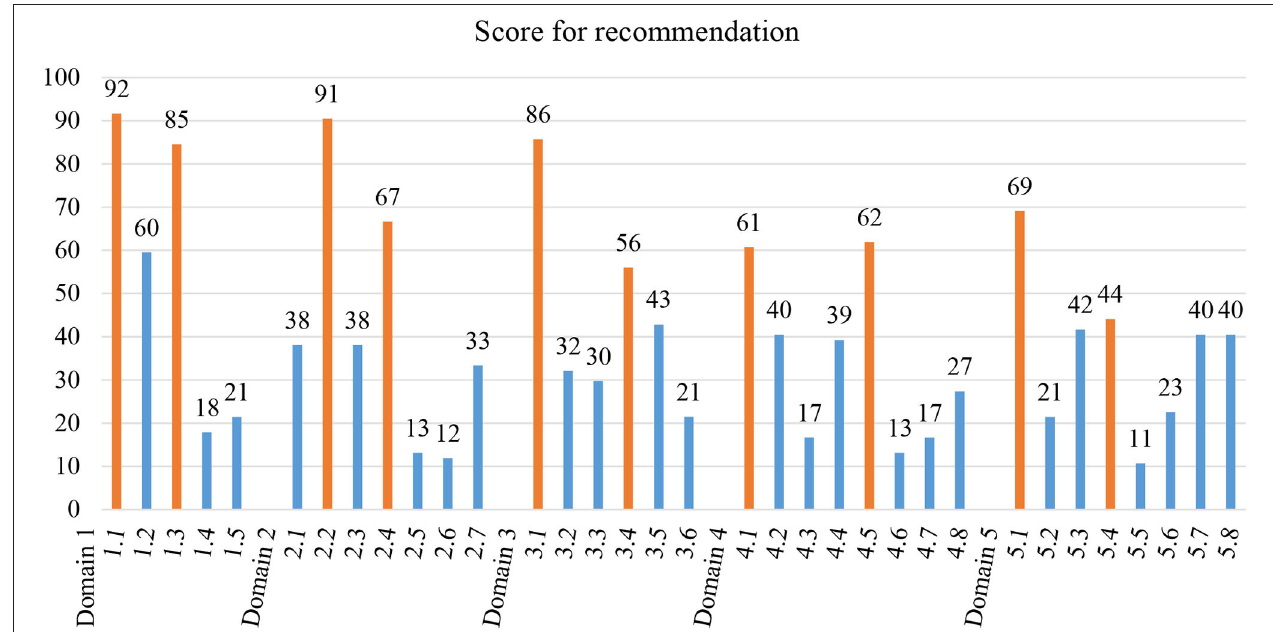
FIGURE 1 | Item selection after expert’s consensus based on the score for recommendation, presented as the average percentage of the four criteria. The top two items with the highest average percentage were considered to reach expert’s consensus and selected to constitute the rapid assessment of the ASPC scale, which were highlighted in orange. Details of the items and domains could be found in Appendix 1